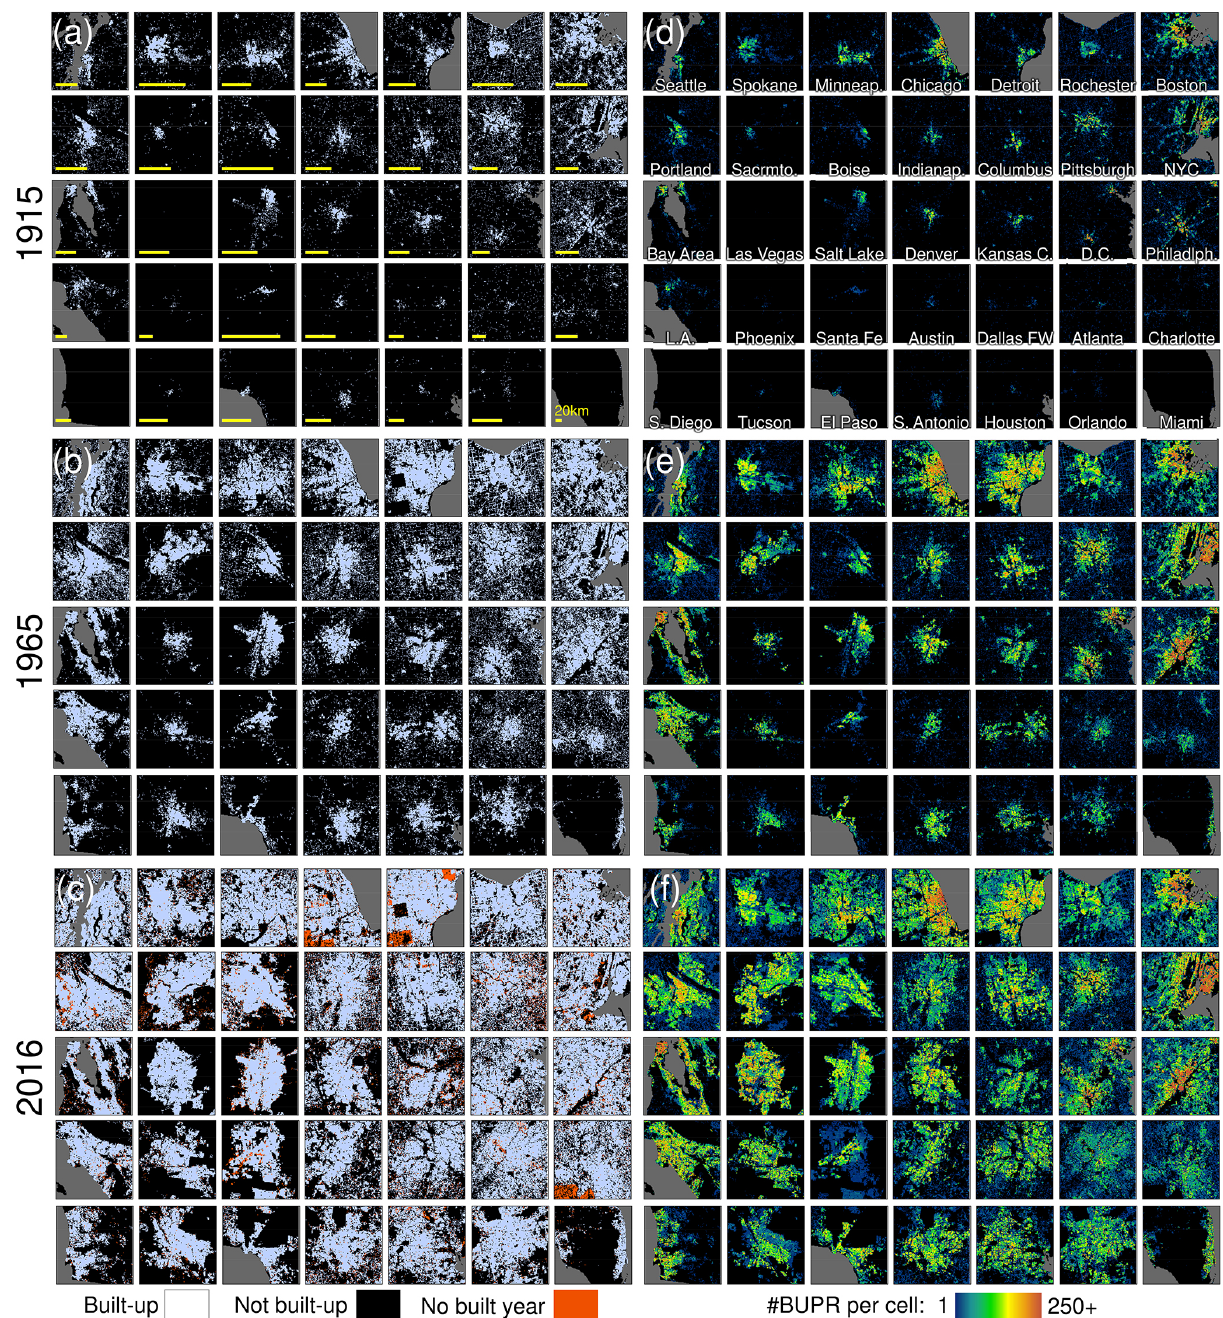
Figure 3. Built-up area (BUA) surfaces for 35 selected US cities in (a) 1915, (b) 1965, and (c) 2016 and (d–f) corresponding BUPR surfaces. Cities are arranged in a quasi-geographic space, e.g. northeastern cities shown in the upper right part of the panels. Panel (c) also shows grid cells where no built-year information is available. Note that cities are depicted at individual scales; see 20km scale bars in panel (a) and Fig. B1 for size relationships between shown